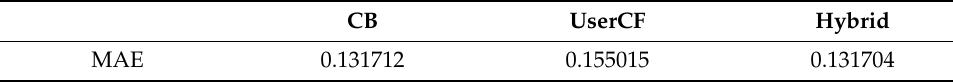
Table 2. Comparison of MAE of different recommendation approaches.